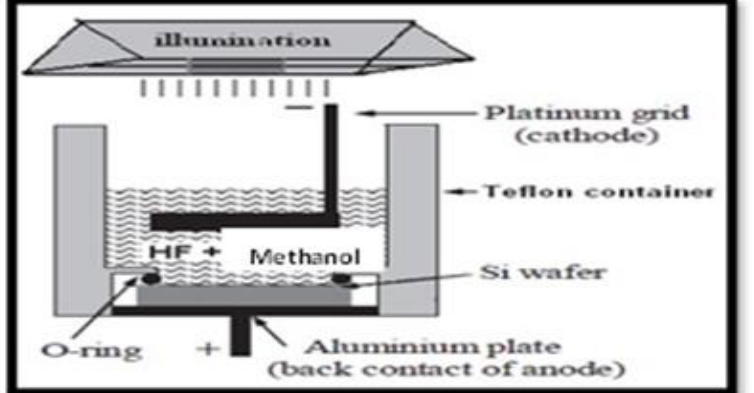
Figure 2: Schematic of the experimental setup of the illumination assisted